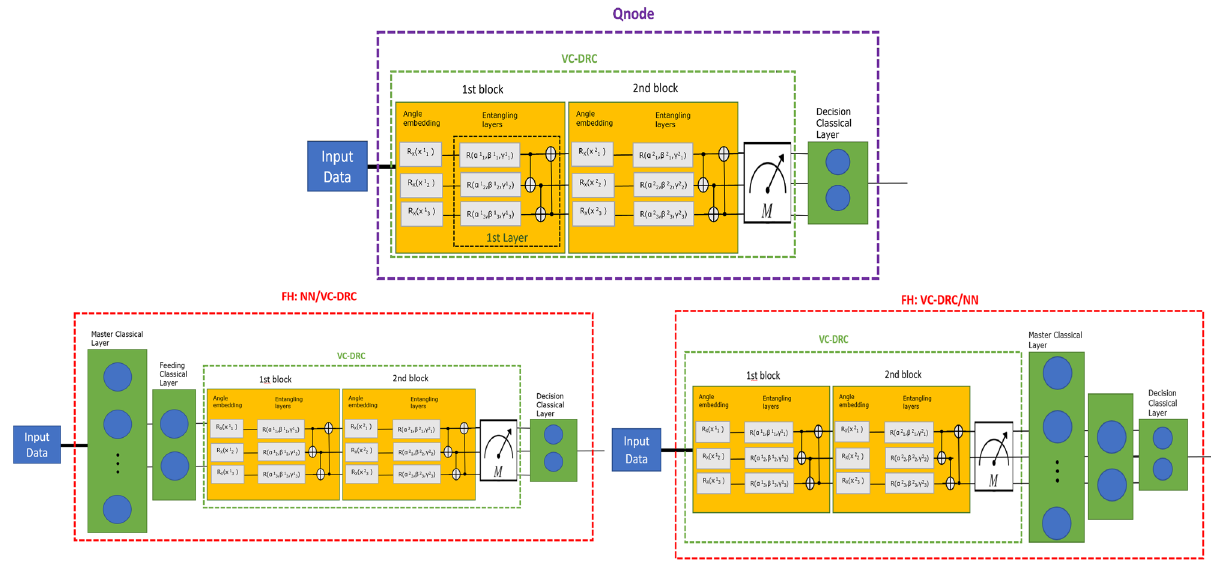
Figure 12. (First row) Block Diagram of the specific QNode proposed in the current study. (Second row left) Block Diagram of the Full Hybrid (NN/VC–DRC) classifier where a VC–DRC circuit is placed after a classical neural network, (Second row right) Block Diagram of the Full Hybrid classifier where a fully quantum VC–DRC circuit is placed before classical neural network